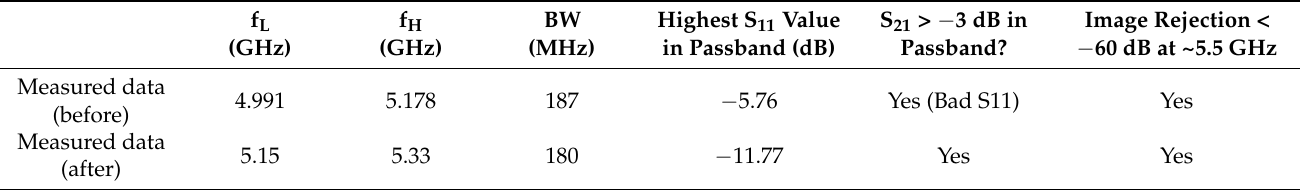
Figure 16. Measured ( a ) S 11 ( b ) S 21 values of the filter before laser trimming and after laser trimming (measurements and simulation results).